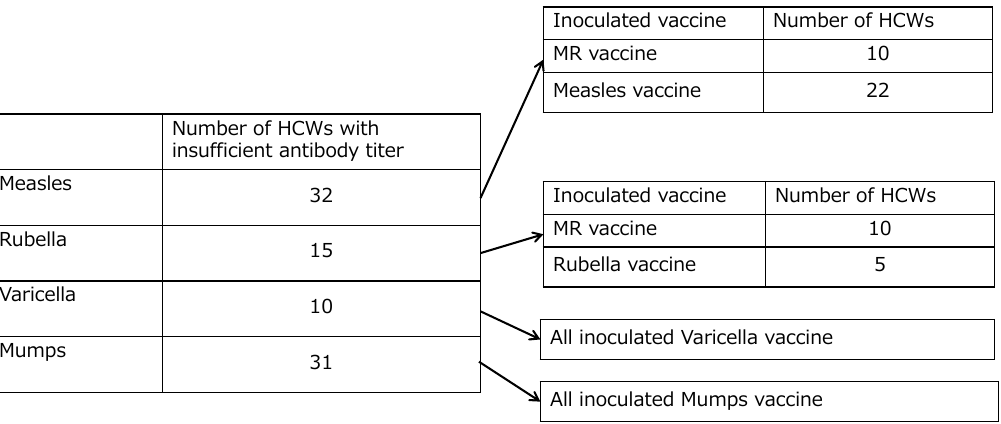
Figure 1 : Number of people who did not have enough antibody titer to measles, rubella, mumps, or varicella are shown on the left half of the figure. HCWs who were short of measles and rubella antibody were inoculated with measles-containing and rubella-containing vaccine, respectively. The breakdowns of measles-containing vaccine and rubella-containing vaccine are shown on the top right half of the figure. HCWs: health care workers MR vaccine: measles-rubella combined